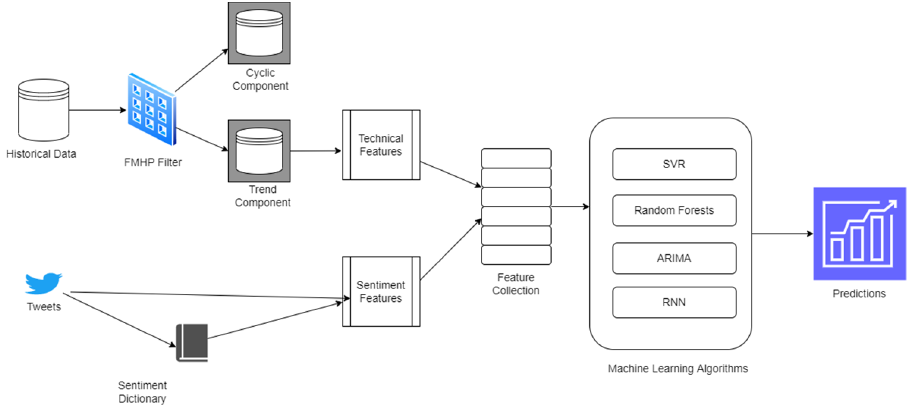
Figure 1. The proposed model.